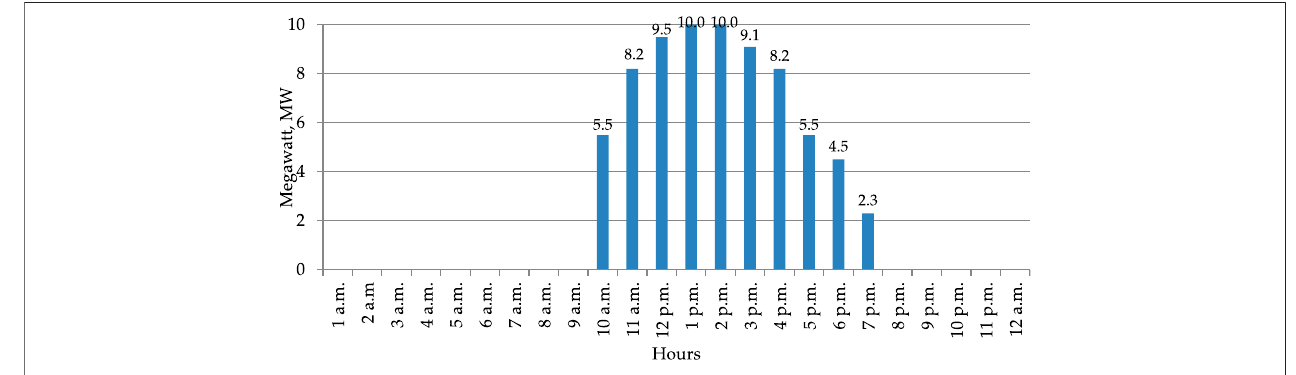
FIGURE 2 | Daily irregularity of electricity generation at a 10 MW solar power plant in the Orenburg region (average value, 2019).